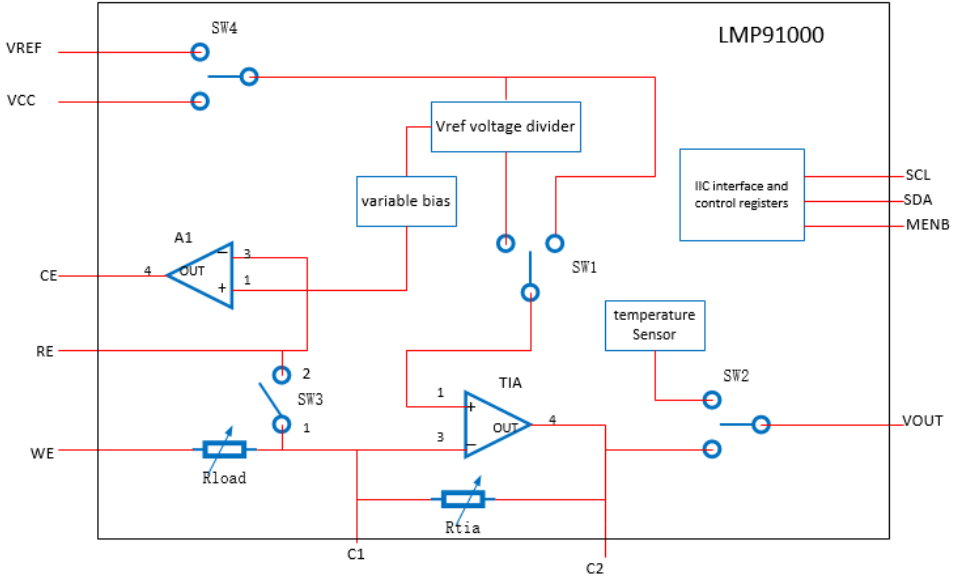
Figure 4. Working principle diagram of LMP91000.